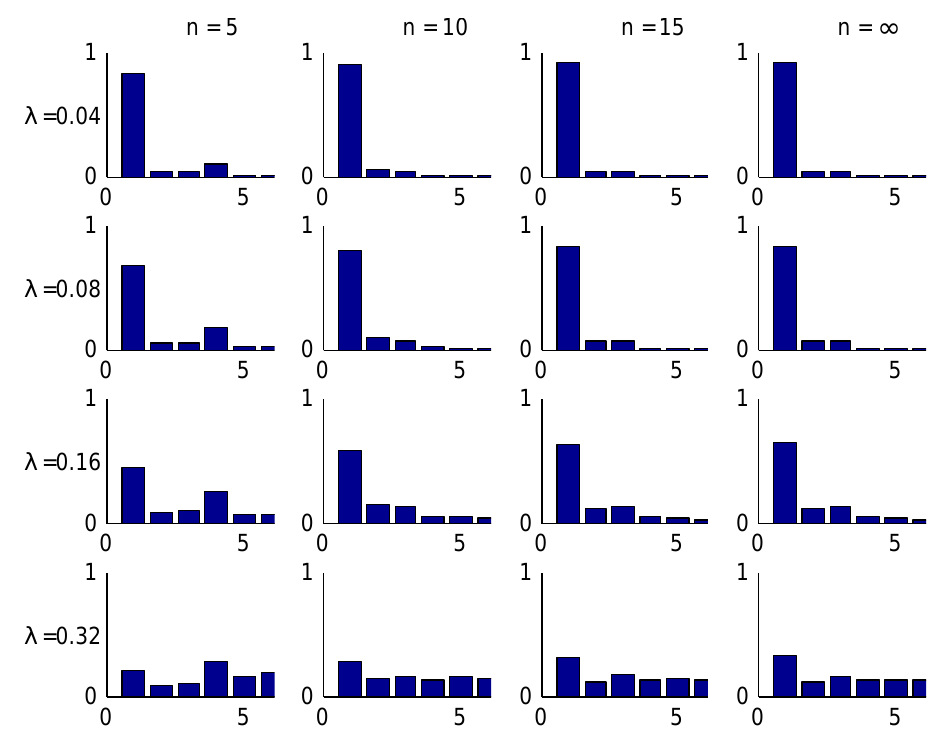
Figure 3. Transient distributions,